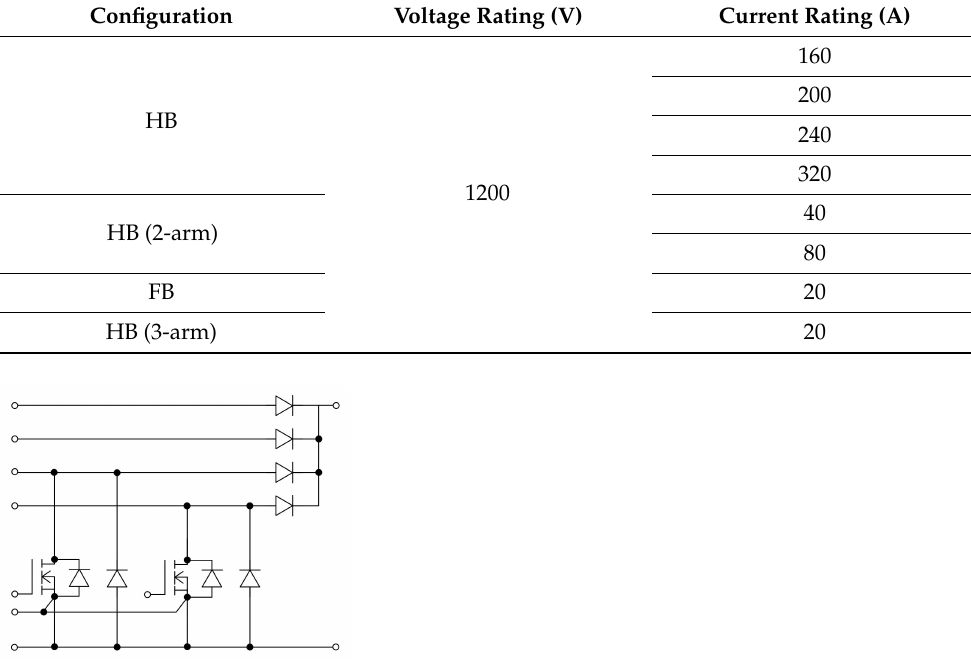
Figure 7. Configurations of Infineon Technologies SiC switching modules DF23MR12W1M1P_B11, DF23MR12W1M1_B11, DF11MR12W1M1P_B11, and DF11MR12W1M1_B11